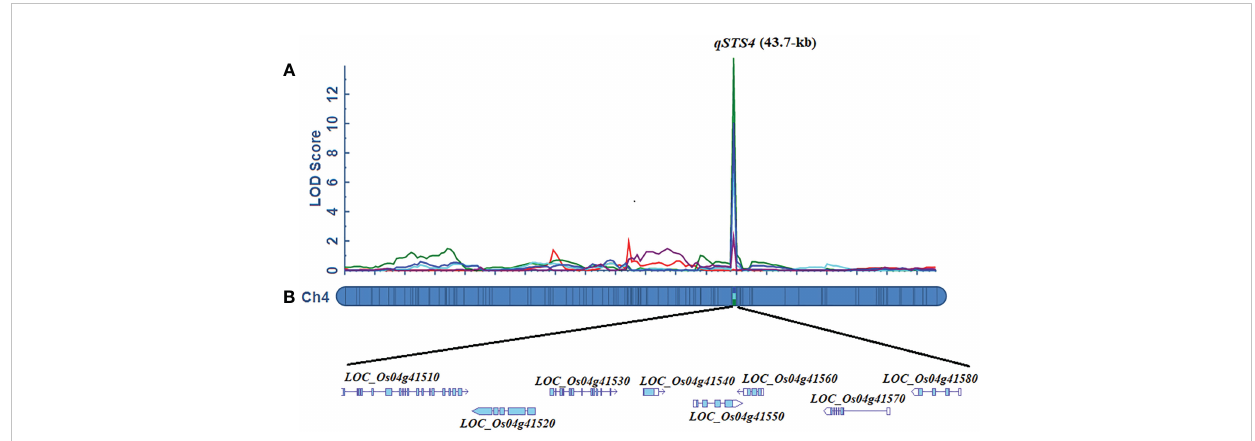
FIGURE 3 Fine mapping of the qSTS4. (A) Localization of qSTS4 based on high-density mapping by ICIM module of QTL IciMapping 4.2. (B) Putative salt genes identi fi ed at qSTS4 using annotation information from the ‘ Nipponbare ’ reference genome (http://plants.ensembl.org/index.html/).